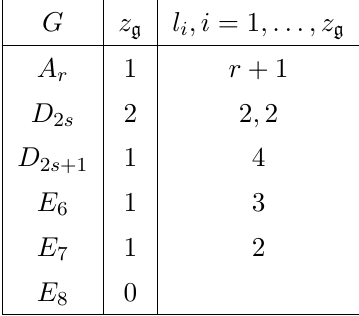
Table 1 . The number of cyclic factors in Z with their